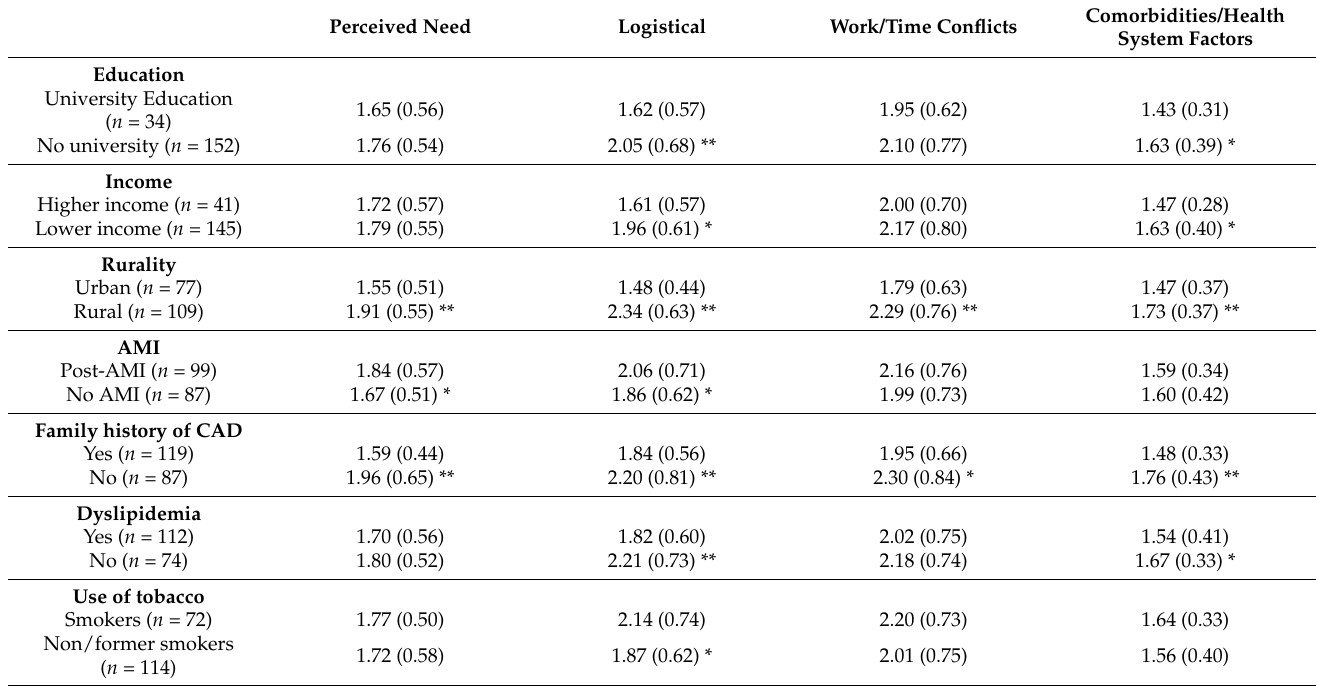
Table 4. Criterion and construct validity of the CRBS-CZE ( n =